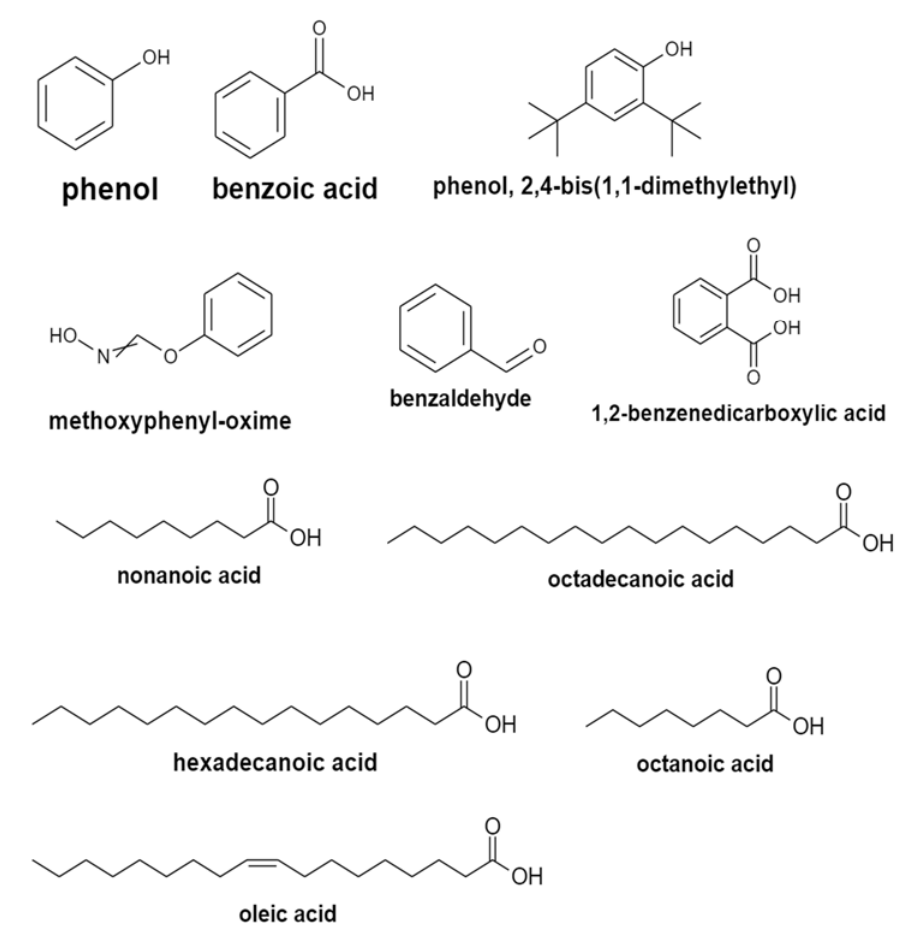
Figure 2. Structure of the components identified from Bacillus spp. isolates.